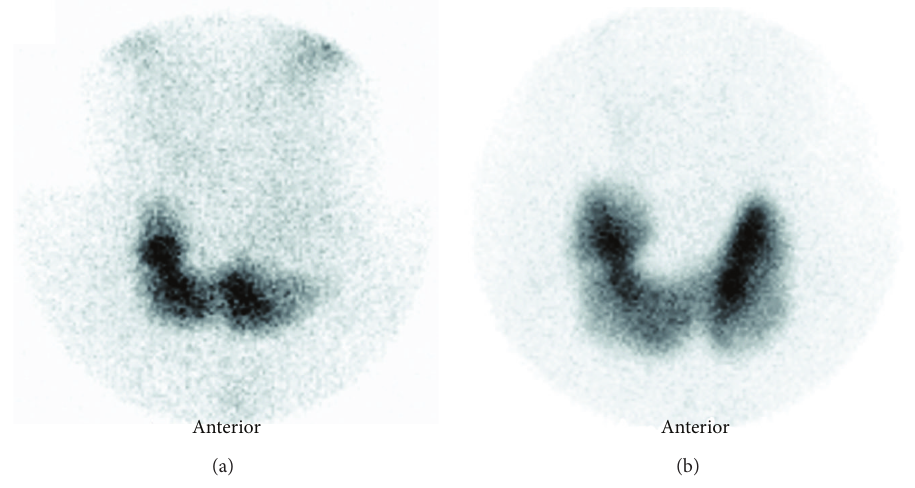
Figure 2: Thyroid scintigraphy using 99 m Tc-pertechnetate. (a) Preoperative anterior planar image shows a large hypoactive area in upper and middle poles of the left thyroid lobe. (b) Postoperative anterior planar image demonstrates an increased focal uptake in the middle and upper poles of the left thyroid lobe.